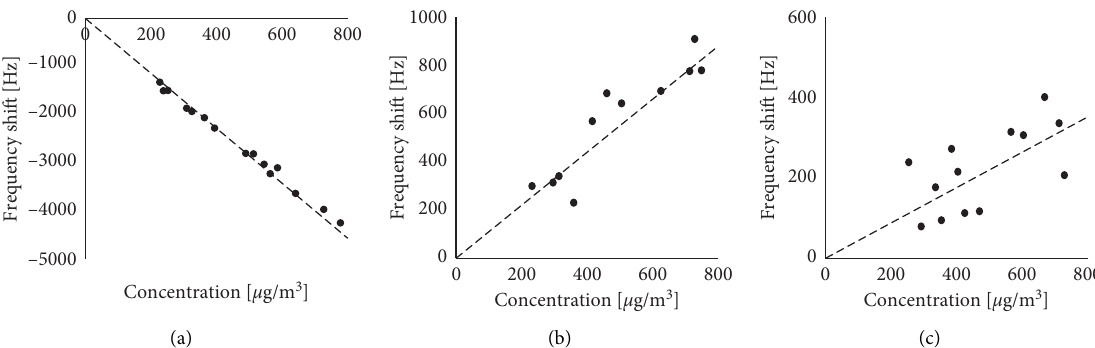
Figure 9: The frequency shift of the 315MHz SAW vs. the concentration of aerosols generated by (a) 1 μ m, (b) 3 μ m, and (c) 10 μ m PTFE particles, measured in the 7L